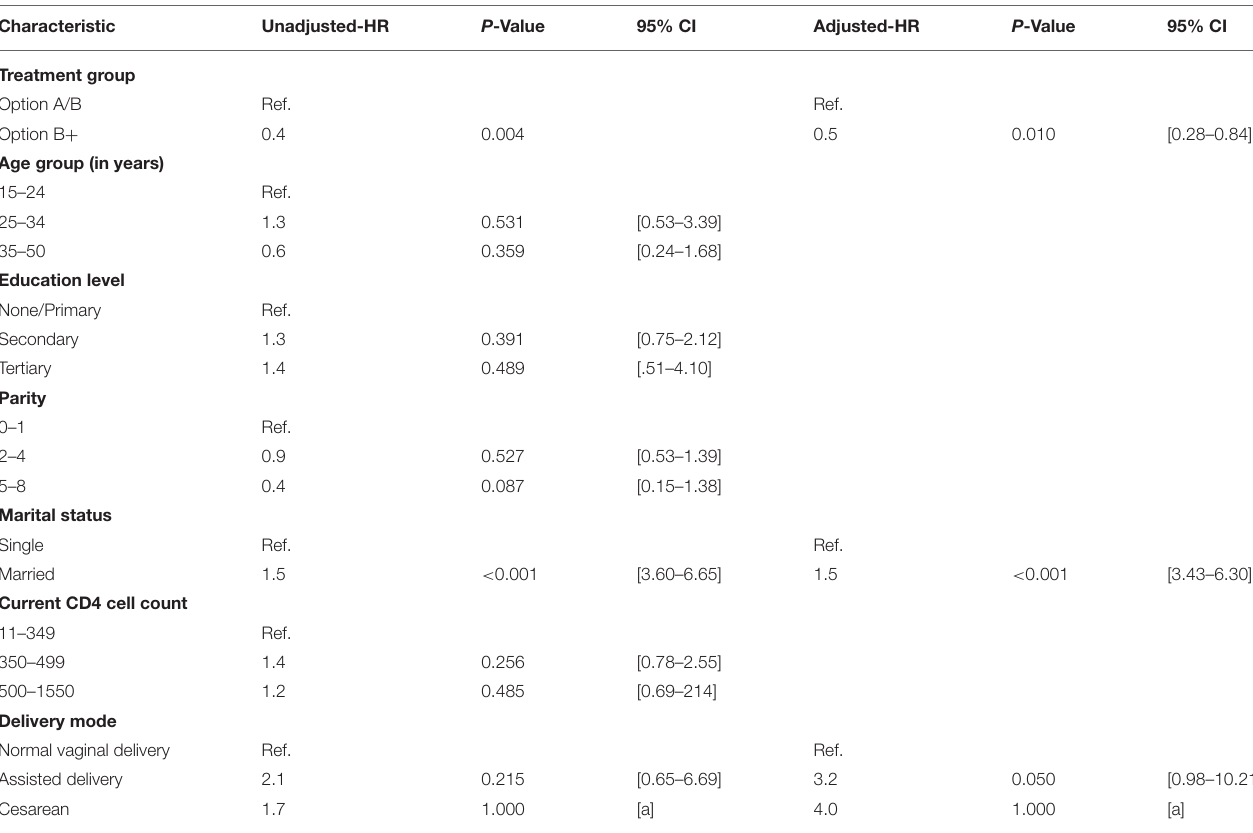
TABLE 4 | Cox proportional hazard analysis of background characteristics and Regimen type of HIV Positive woman from Zambia SmartCare routinely collected data, 2018.